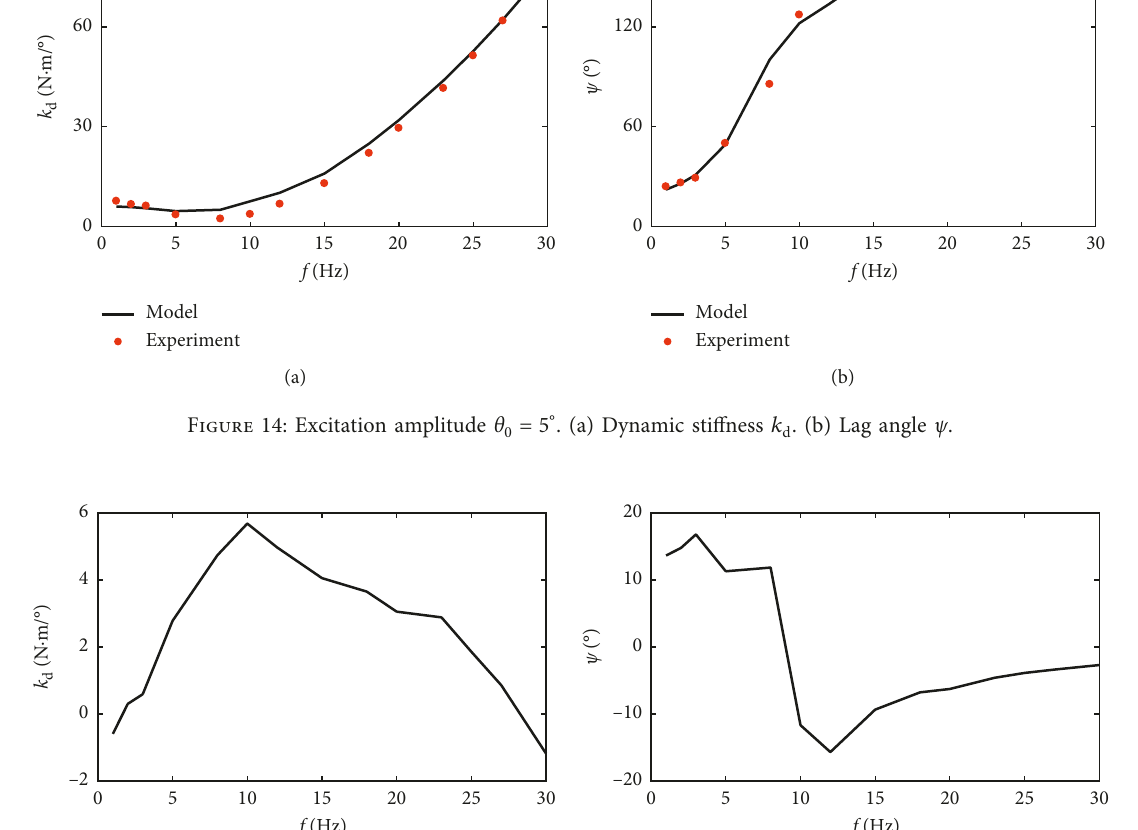
. 5 ° . (a) Dynamic stiffness error k 0 (cid:31) 2